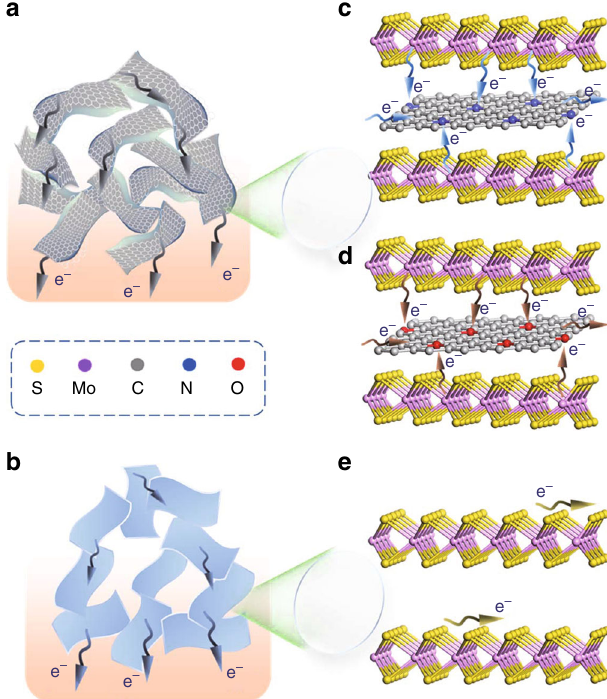
Fig. 6 Schematic illustration of different electron transport pathways. a , b Electron transport pathways between MoS 2 nanosheets in the MoS 2 -based heteroaerogels ( a ) and pure MoS 2 powder ( b ). c , d Electron transport pathways across MoS 2 monolayers in the MoS 2 /NC heteroaerogel ( c ) and MoS 2 /C heteroaerogel ( d ). e Electron transport pathways within MoS